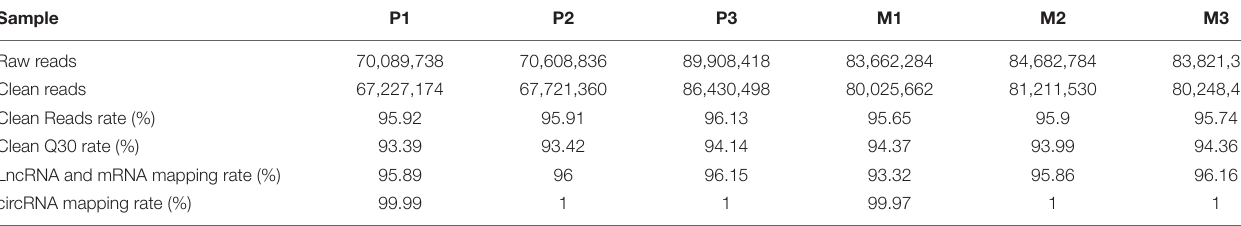
FIGURE 1 | Growth morphology of adipocytes in different periods. (A) Non-adherent cells are spherical. (B) The adherent cells are irregularly shaped, and the cells are photographed on the fourth day of culture. (C) The lipid droplets in differentiated adipocytes can be stained red by Oil Red O, and the cells are photographed on the 12th day of culture. Scales bar: 50 µ m. TABLE 1 | Alignment and quantification statistics in each sample RNA-Seq library.